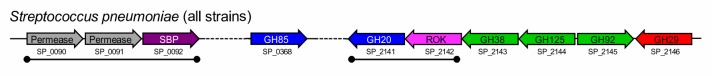
Organization and conservation of a Carbohydrate Processing Locus (CPL) and other accessory proteins predicted to be associated with N-glycan processing.Genetic organization of a CPL and other accessory ORFs present in strains of S. pneumoniae whose protein products are putatively associated with N-glycan processing. The CPL consists of a characterized α-(1,6)-mannosidase (SpGH125) [21], two putative α-mannosidases (SpGH38 and SpGH92), a predicted α-fucosidase (GH29), a putative sugar kinase (ROK) and a known exo-β-hexosaminidase (SpGH20C) [28]. Other conserved proteins predicted to be associated with N-glycan processing include a characterized endo-β-N-acetylglucosaminidase (SpGH85 or EndoD) that is active on the core of N-linked glycans [24] and an ABC transporter (ABCNG) that consists of a predicted solute binding protein (NgtS) and two putative permeases (NgtP1 and NgtP2). Locus tags shown underneath ORFs relate to the TIGR4 genome; black bars underneath ORFS indicate genes that are predicted to be co-transcribed. For the majority of the ORFs, coloring corresponds to the type of configured sugar acted on by the hydrolase: fucose (red), glucose (blue) and mannose (green).